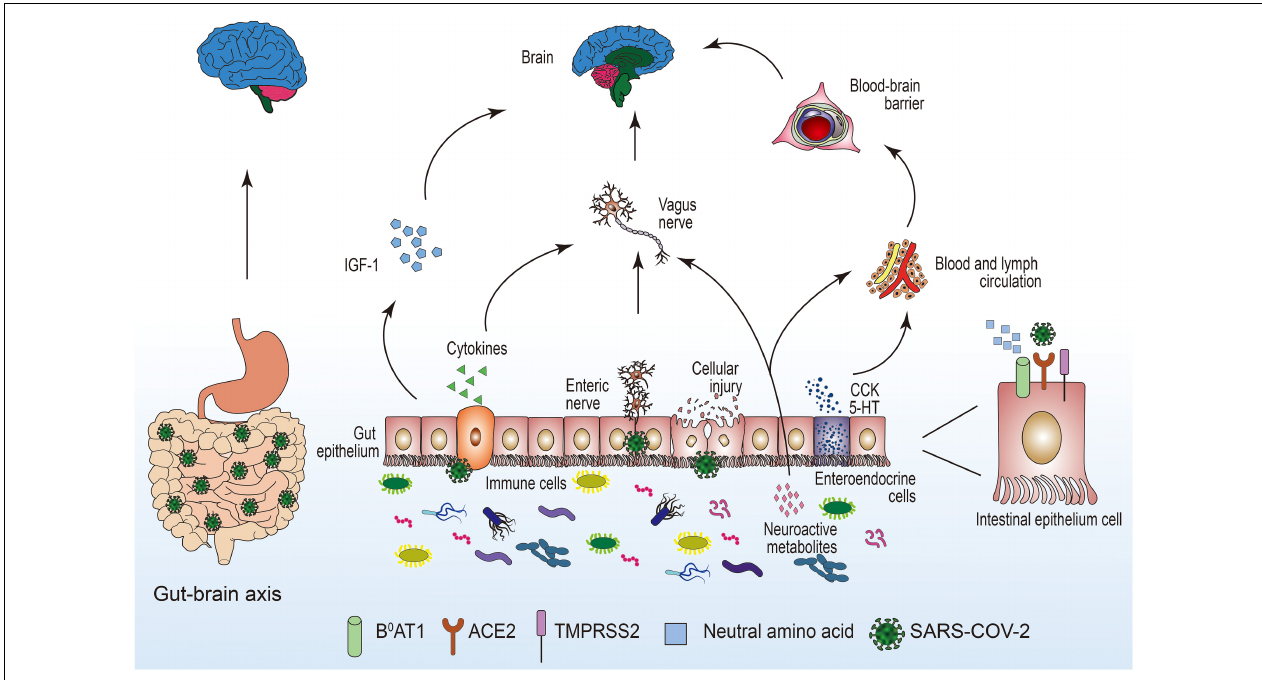
FIGURE 1 | The potential pathways for the invasion of SARS-COV-2 to the central nervous system through the intestinal tract. 5-HT, 5-hydroxytryptamine; ACE2, angiotensin-converting enzyme 2; B 0 AT1, amino acid transporter; CCK, cholecystokinin; IGF-1, insulin-like growth factor-1; SARS-COV-2, severe acute respiratory syndrome coronavirus 2; TMPRSS2, transmembrane serine